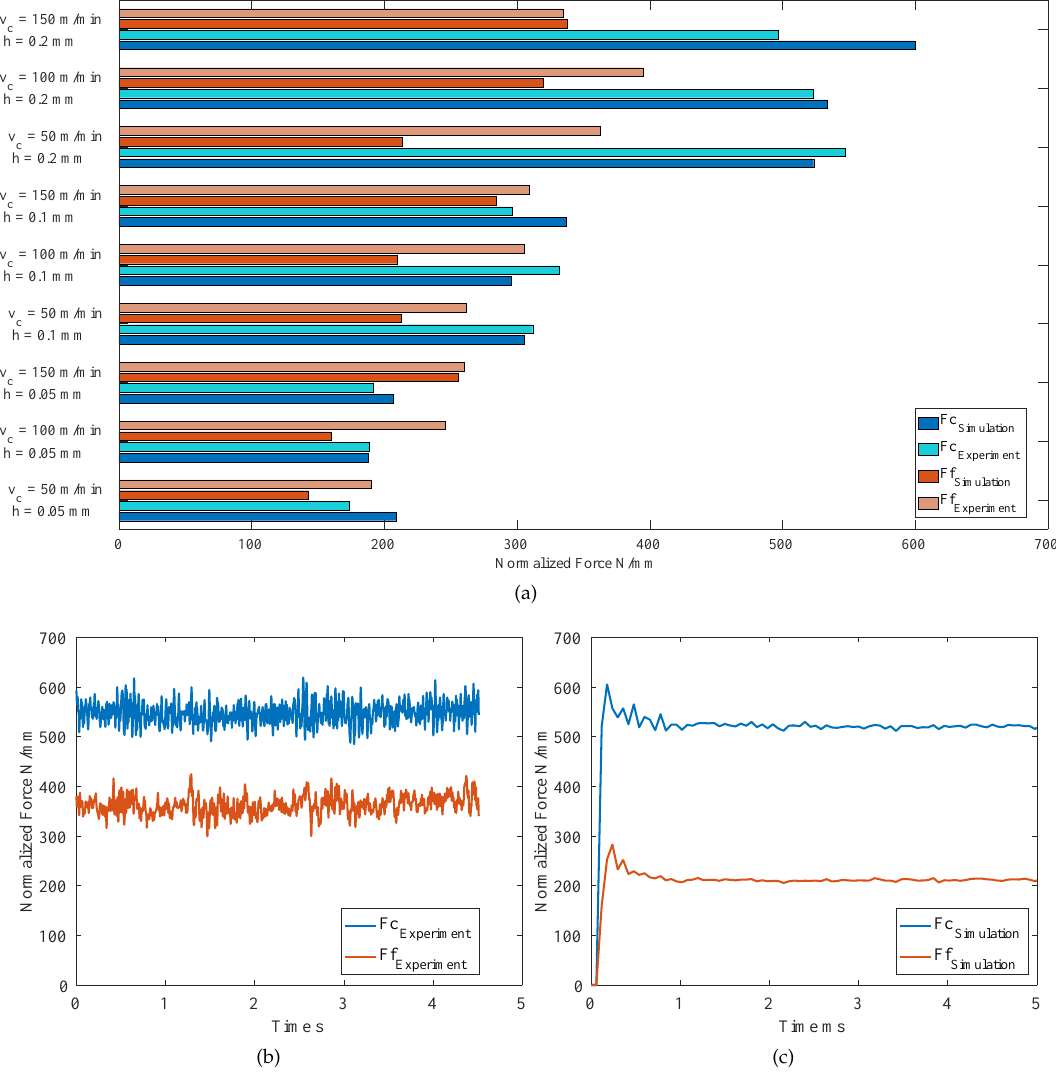
Figure 3. Normalized cutting forces F c and feed forces F f from simulation and experiment. ( a ) Comparison of the simulated and experimentally measured cutting force components at different cutting speeds and undeformed chip thicknesses; ( b ) Experimental force measurements under the cutting condition v c = 50 m/min and h = 0.2 mm; ( c ) Cutting force components from CEL model under the cutting condition v c = 50 m/min and h = 0.2